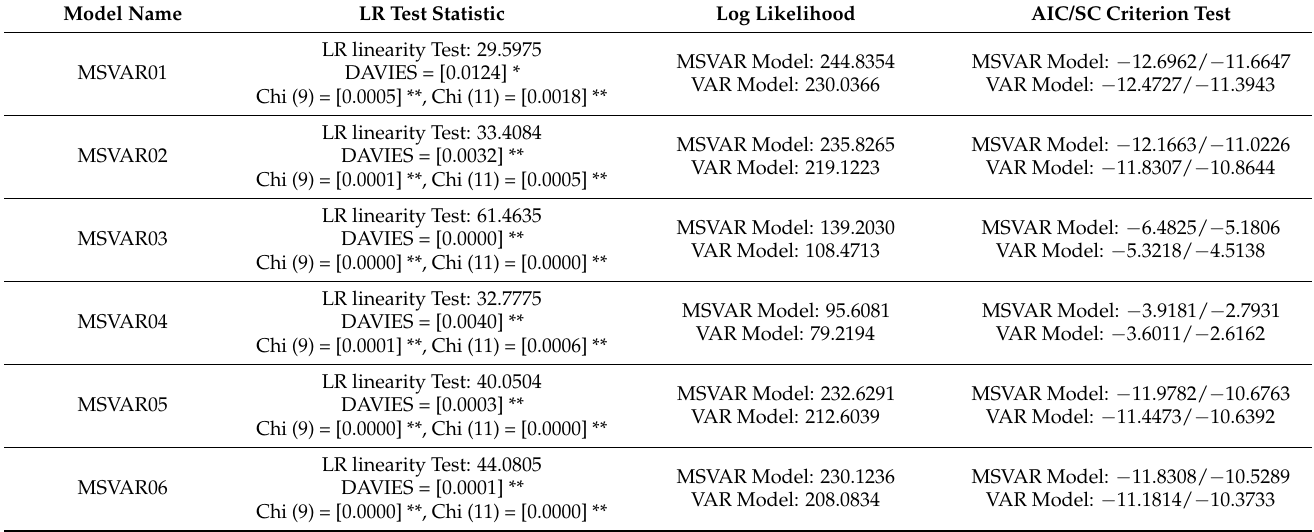
Table 3. MSVAR Model Test